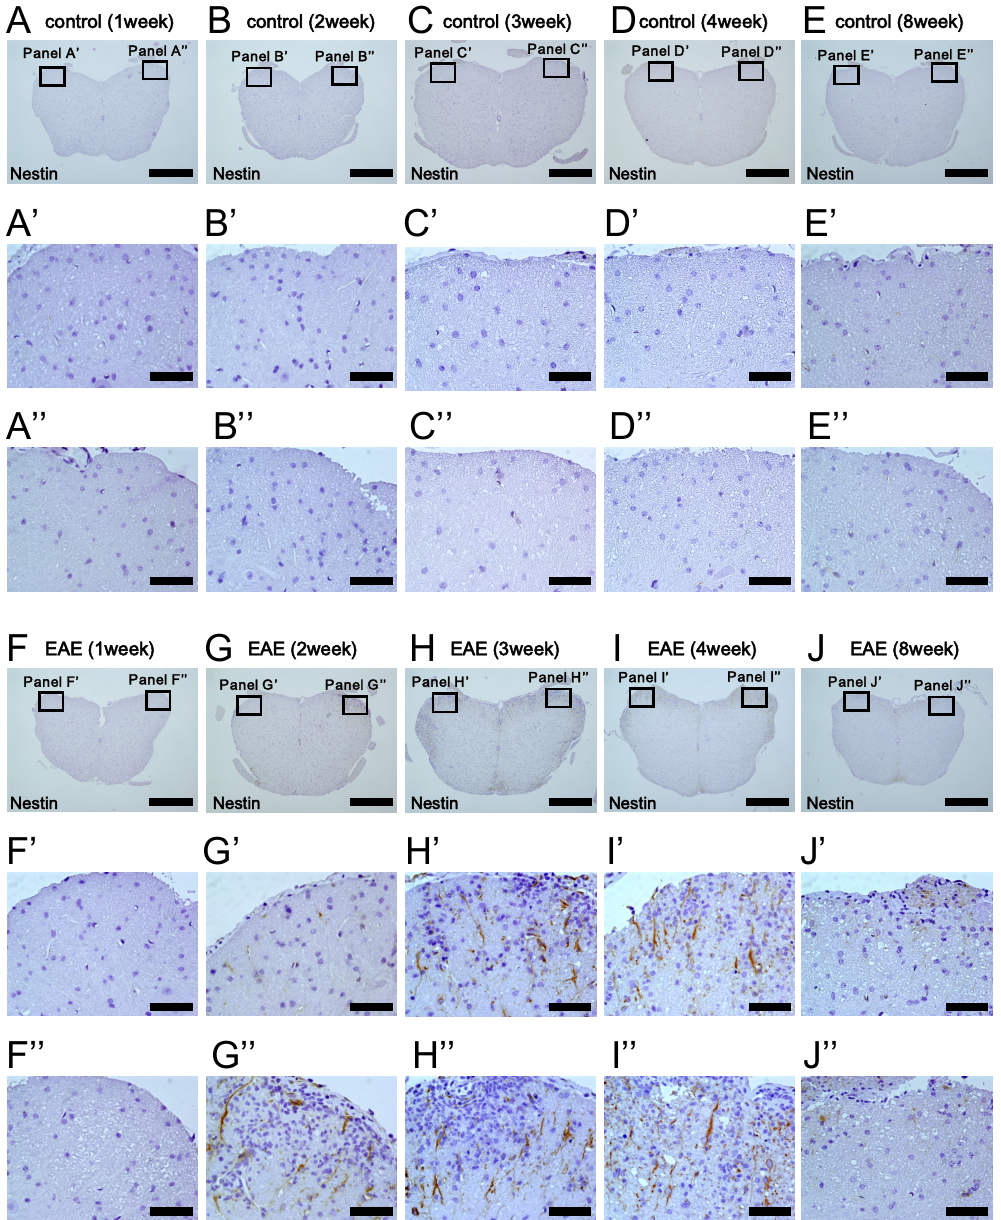
Figure 6. Immunohistochemical analysis for Nestin expression of lumbar spinal cord at 1 ( A , A ’, A”